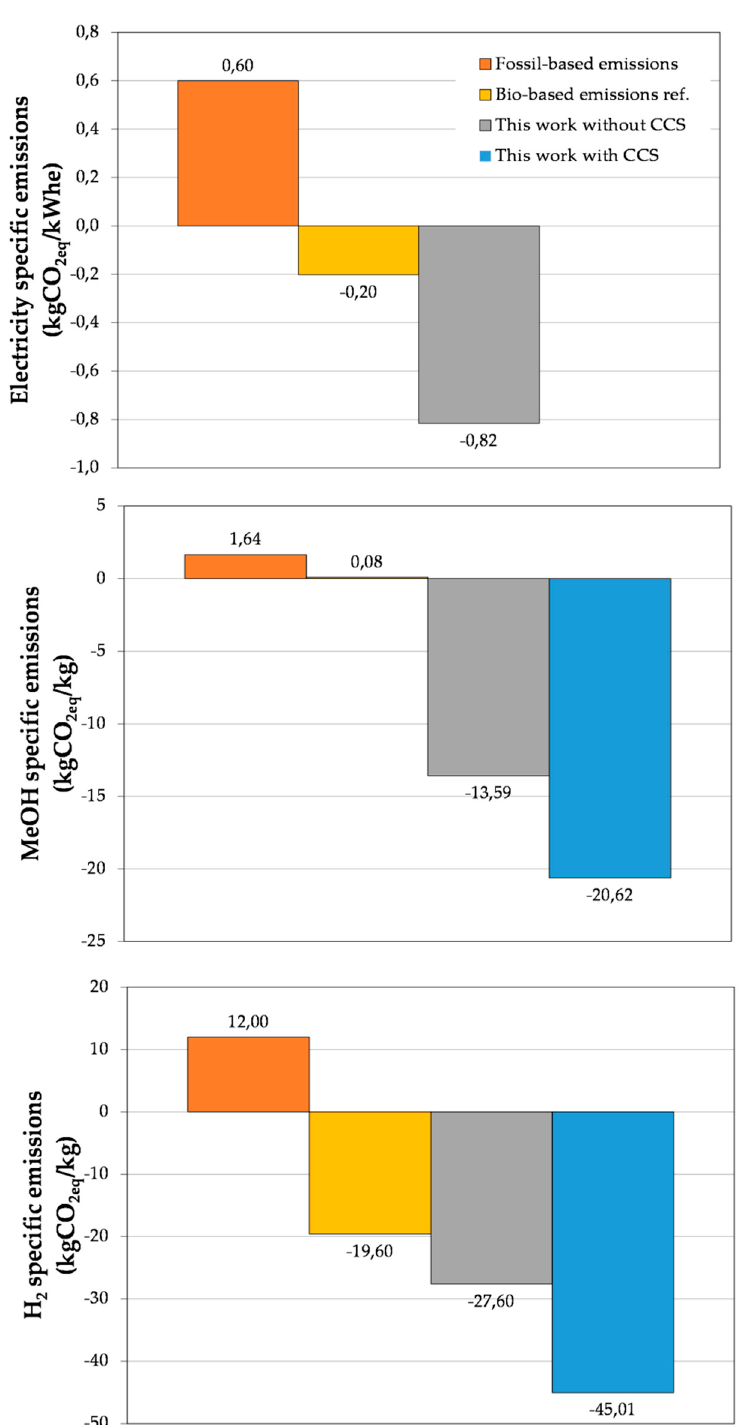
Figure 9. Equivalent CO 2 emissions / savings comparison for each case and between fossil-based production (orange bars), biobased production in the literature from Reference [79] (yellow bars), and present work without (gray bars) and with (blue bars) CO 2 storage.